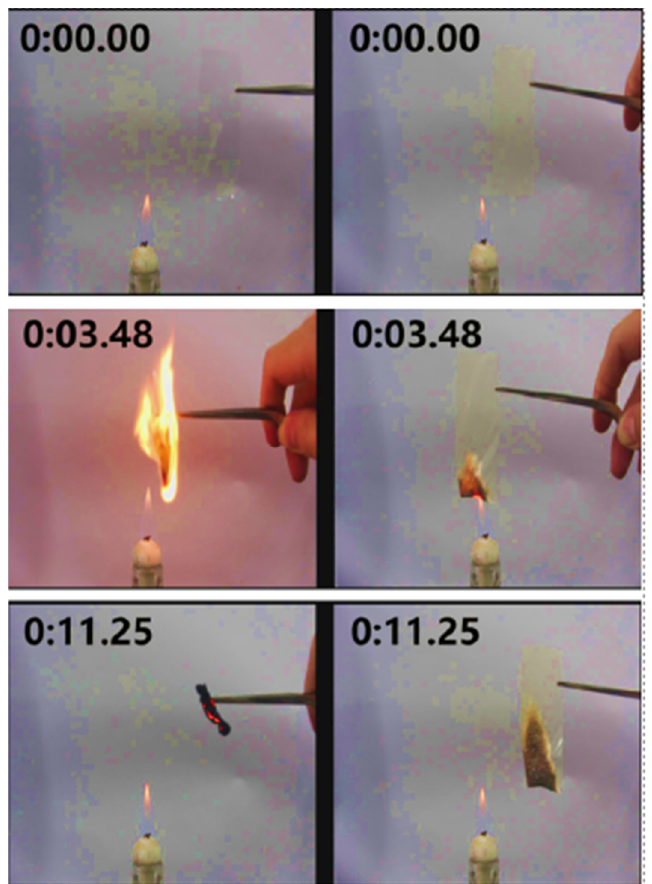
Figure 5. Time-lapse flammability of (left) pure nanofibrillated cellulose film and (right) transparent hybrid film with 50 wt.% monolayer clay nanoplatelet, respectively [113]. Reproduced with permission from ACS.